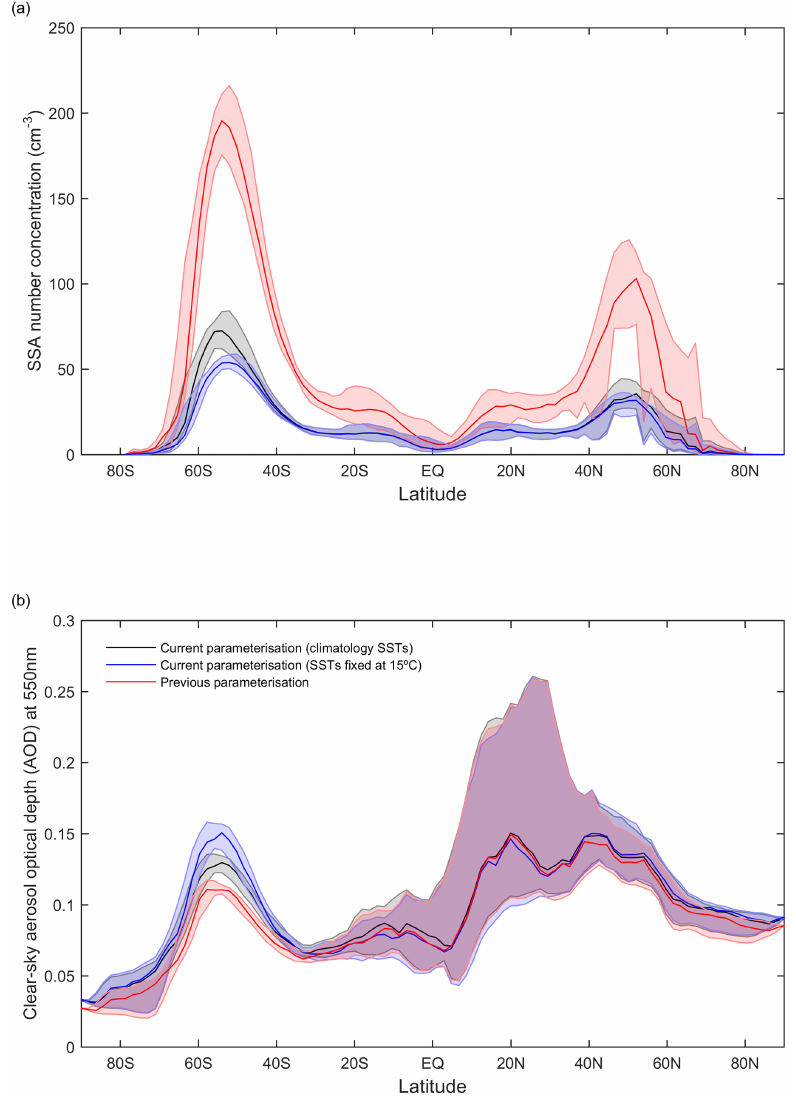
Figure 8. (a) Annually averaged (median) sea spray aerosol number concentration in the lowest model layer computed during the three NorESM runs. (b) Zonally and annually averaged clear-sky aerosol optical depth at 550nm computed during the three NorESM runs (me- dian). Shaded areas represent the 25th and 75th